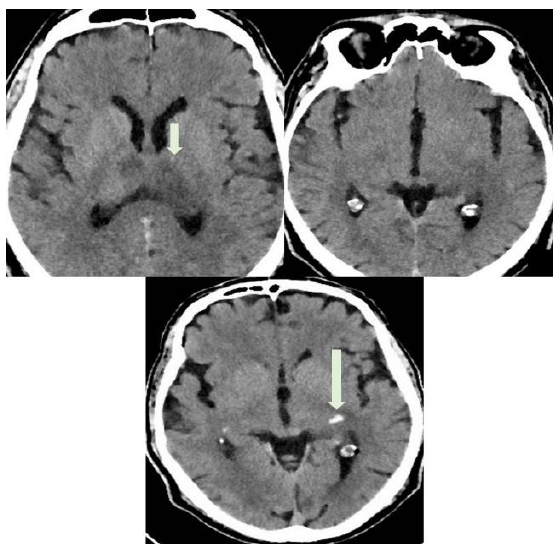
Figure 4. A CT with use of a medium contrast was performed the following day to better appreciate the vascular extension of the thrombosis. In the figure, axial CT images show hypodense areas in thalami and left parahippocampal region (short arrow, ischemic stroke lesions) and spontaneously hyperdense focus in left parahippocampal region (long arrow). This last was interpreted as a focal hemorrhagic transformation of the stroke. CVT in COVID-19 disease has been associated with a strong activation of the inflammatory chain. Specifically, it has been proven the implication of neutrophil extracellular traps (NETs), impaired systemic microcirculatory function, downregulation of natural anticoagulation phenomena and vascular endothelial dysfunction. Alveolar capillary micro- thrombi from COVID-19-induced immunothrombosis have been also described [3]. Other studies have reported CVT after vaccination against COVID-19 [6]. Thrombotic thrombocytopenia and cer- ebral venous sinus thrombosis have been observed in patients after receiving the adenovirus-based vaccine (AstraZeneca) and after the first dose of the mRNA-based vaccine, as in our case. Of note, a pathological mechanism which causes CVT in these cases has been postulated, known as “vaccine - induced immune thrombotic thromboc ytopenia” (VITT) [7]. Low platelet count and high D-dimer values, as in our case, can assist the diagnosis of VITT after vaccination [8].